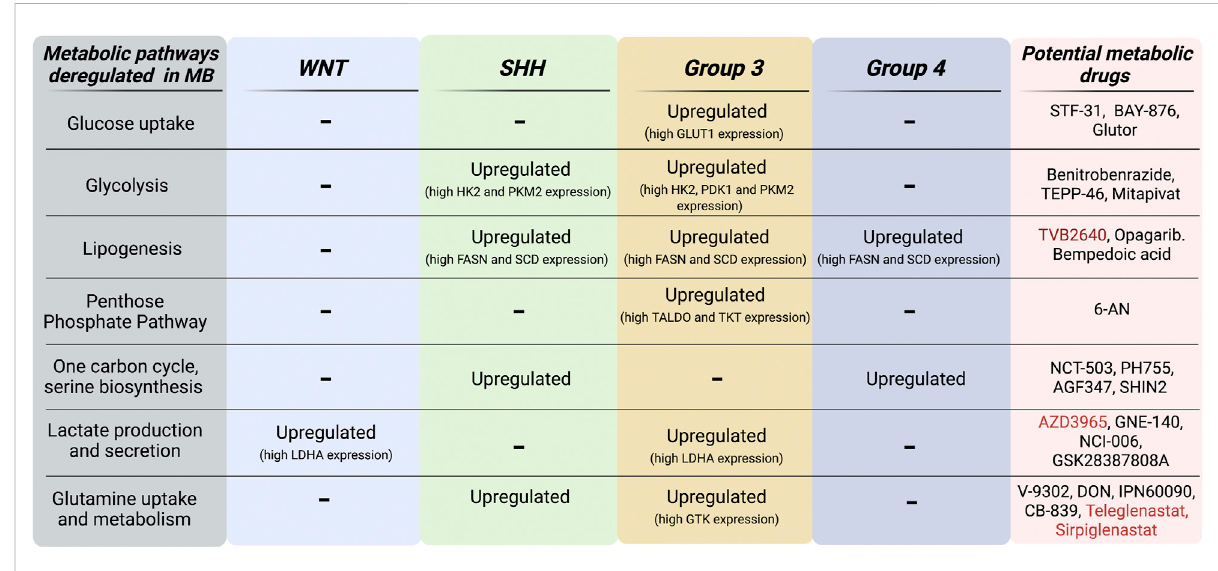
FIGURE 4 MB subgroup-speci fi c alterations of metabolic pathways. Schematic representation of both metabolic pathways and genes that are found upregulated in MB subgroups. Metabolic inhibitors currently in preclinical ( black ) and clinical ( red ) development for oncology applications are listed in this scheme. Figure is created in “ BioRender.com ” .